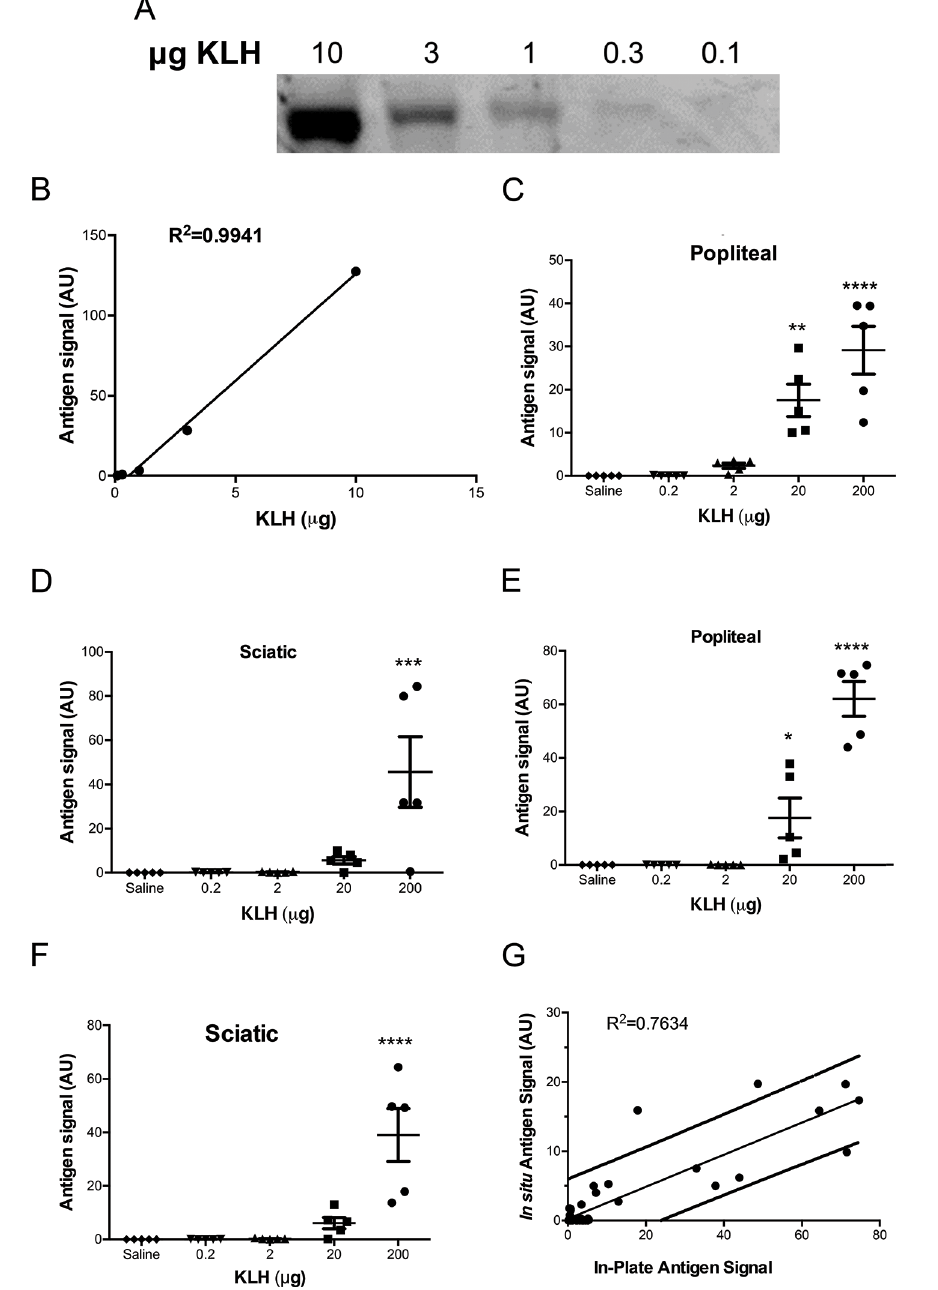
Figure 1. Antigen flow through the lymphatic chain can be monitored with infrared fluorescent dye–labeled antigen. (A) Keyhole limpet hemocyanin (KLH) was labeled with 800CW and run on a polyacrylamide gel. (B) A linear correlation was found between the amount of KLH-800 and the fluorescent signal intensity (Fluorescent antigen signal is expressed as “arbitrary units (A.U.)). (C, D) Increasing amounts of KLH-800 were injected subcutaneously into the dorsum of the hind paw of a Balb/c mouse. The animal was imaged after 1 h; increas- ing amounts of KLH-800 correlated with an increasing fluorescent signal located at both the (C) popliteal and (D) sciatic lymph nodes. Data represent mean ± SEM, n = 5 per concentration. A similar increase in signal was observed in (E) popliteal and (F) sciatic lymph nodes extracted from mice injected with increasing amounts of KLH-800 and minced into T-Per. Data represent mean ± SEM, n = 5 per concentration. (G) A linear correlation was found between in situ signal and in-plate signal with an R-squared value of 0.7634. The dot- ted line indicates the 95% prediction